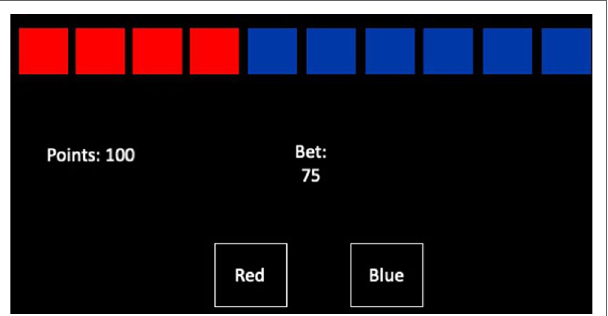
FIGURE 1 | The Cambridge Gambling Task. Participants have to place a bet on whether a token is hidden in the red or the blue boxes at the top. Box color is chosen using the selection boxes at the bottom of the screen. If the bet is correct, the number of points bet is added to their